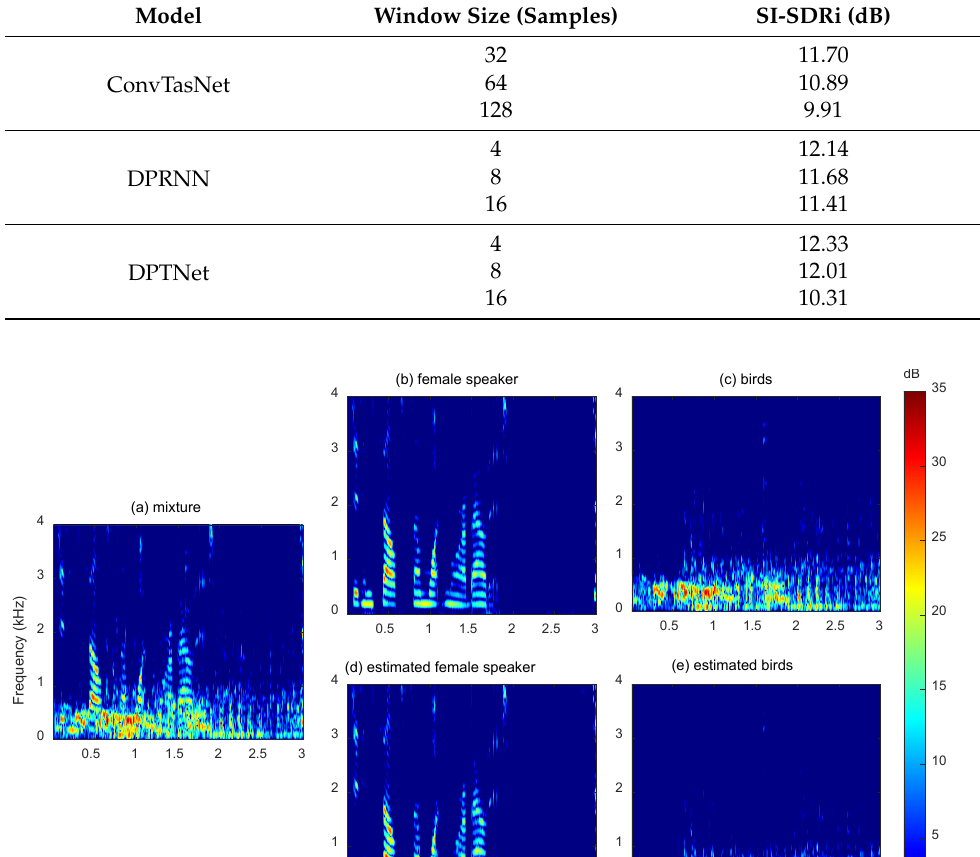
Table 2. Average SI-SDR improvement (dB) on the test dataset for different networks with different window sizes.